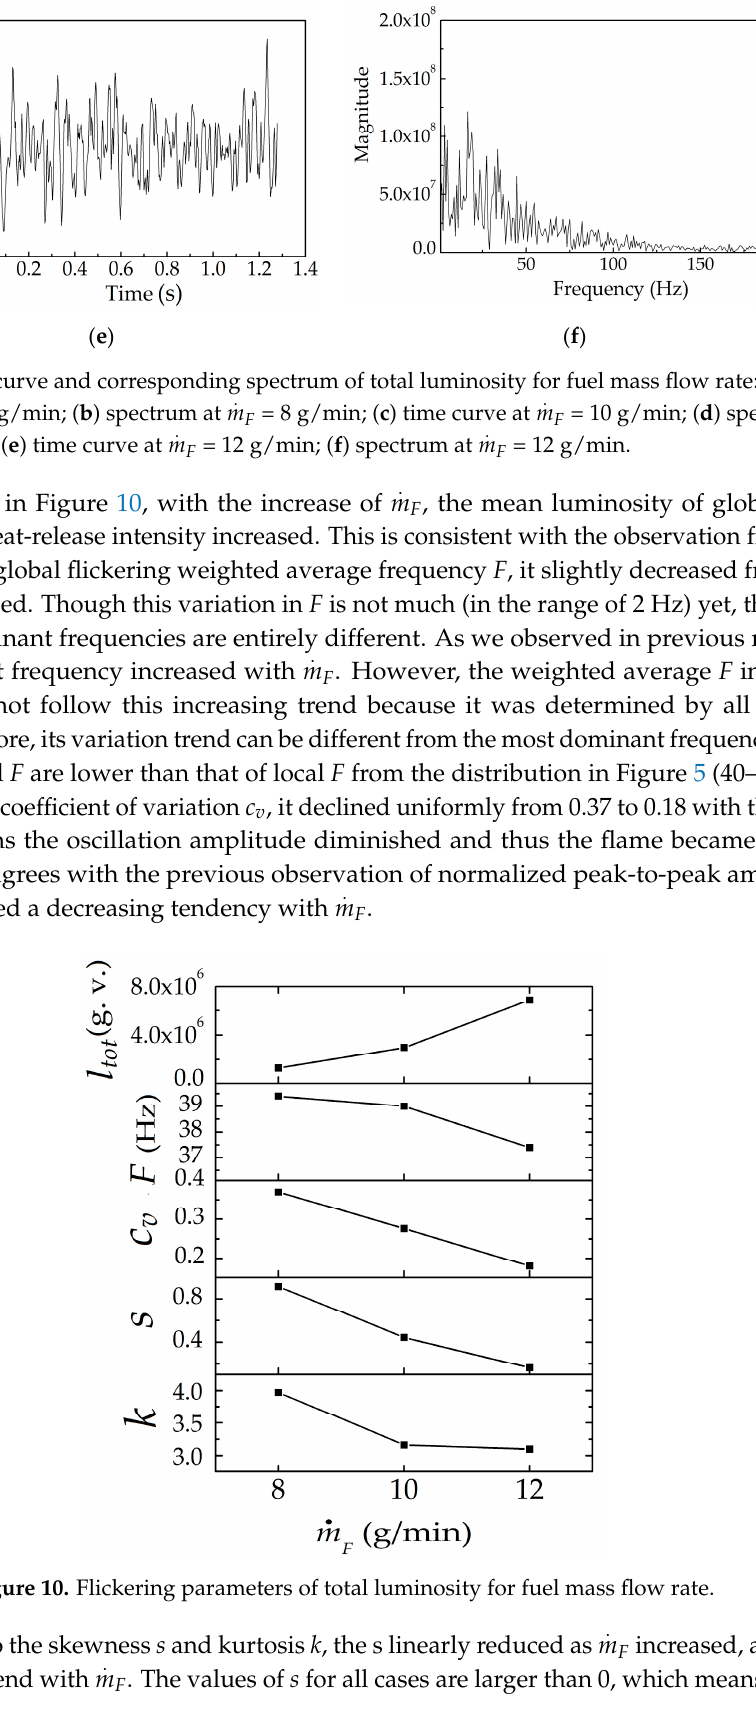
. m F increased, and the k also